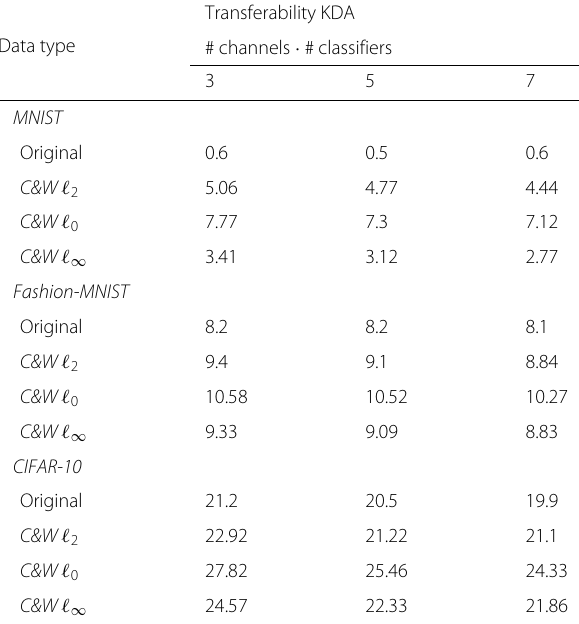
Table 5 Classification error (%) on the first 1000 test samples for the gray-box C&W transferability attacks from a single-channel model to a multi-channel model with randomly selected channels (the average results over 10 runs)